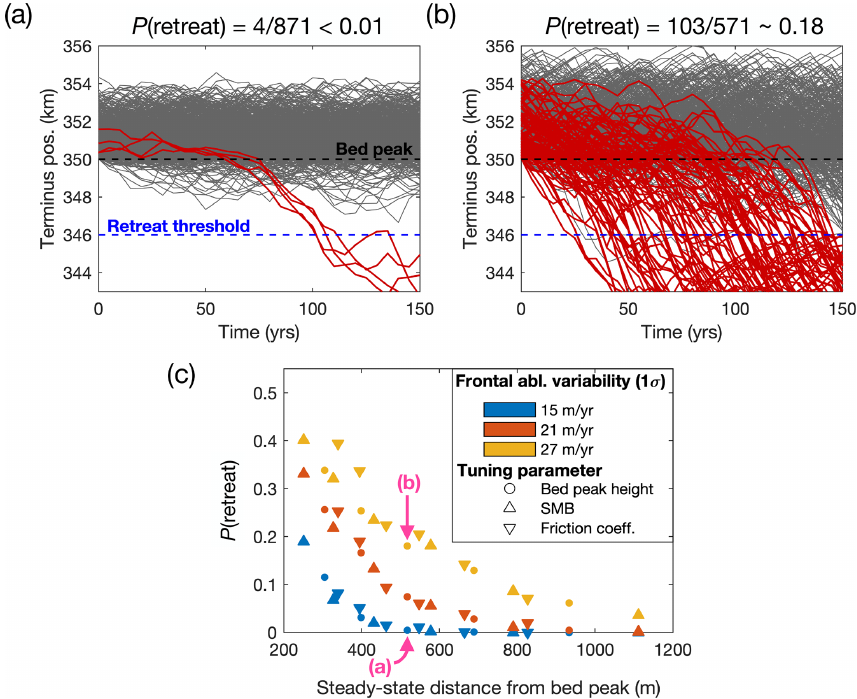
Figure 3. Probability of sustained retreat driven by stochastic variability. (a) An aleatory ensemble experiment with frontal ablation variability of σ FA = 15myr − 1 . Only four simulations (red) produce sustained retreat behind the location of the bed peak (black). Sustained retreat is defined here as retreating past the deepest part of the trough at 346km (blue). (b) An ensemble subject to stronger variability ( σ FA = 27myr − 1 ), in which approximately 18% of simulations produce sustained retreat. (c) Retreat probabilities for a range of bed-peak heights (circles), SMB (triangles), and friction coefficients (downward triangles). Symbols are colored by the range in σ FA . Arrows indicate the ensembles shown in (a) and (b)